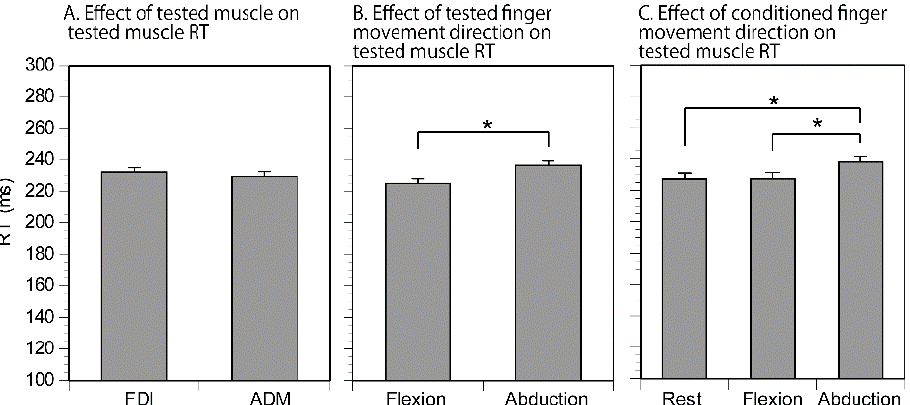
Figure 3. The effect of the tested muscle on the tested RT ( A ), the effect of the tested finger movement direction on the RT ( B ), and the effect of the conditioned finger movement on the RT ( C ). The bars in ( A ) represent the average RT across the tested finger movement directions and conditioned finger movements, the bars in ( B ) represent the average RT across the muscles and conditioned finger movements, and the bars in ( C ) represent the average RT across the muscles and the tested finger movement directions. Bars indicate the mean; error bars indicate the standard error. Asterisks indicate significant differences ( p < 0.05).